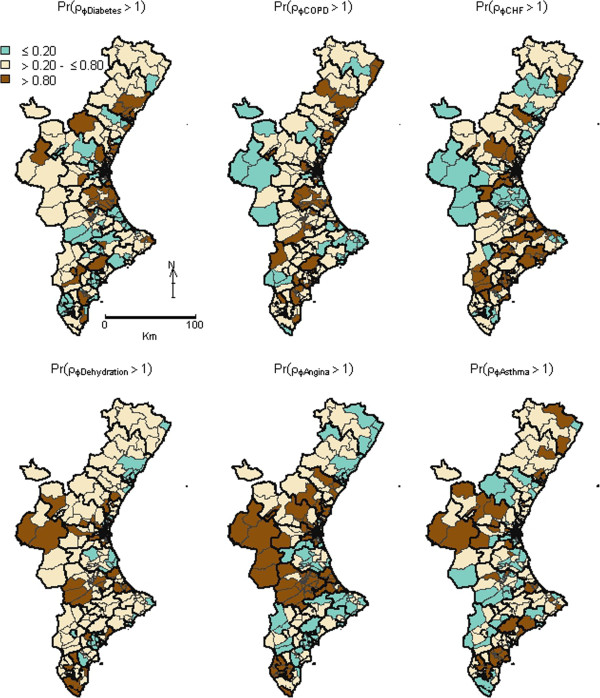
Maps of posterior probabilities that the discrepant component (exp(ϵij)) regarding the shared pattern for the respective Potentially Preventable Hospitalization was higher than 1. Dark-brown coloured territories are BHZ for which the probability of having a relative risk of PPH admissions higher than 1 for the respective discrepant component is >0.8, and green ones are BHZ for which this relative risk is below <0.2. PPH: Potentially Preventable Hospitalizations; BHZ: Basic Health Zones.